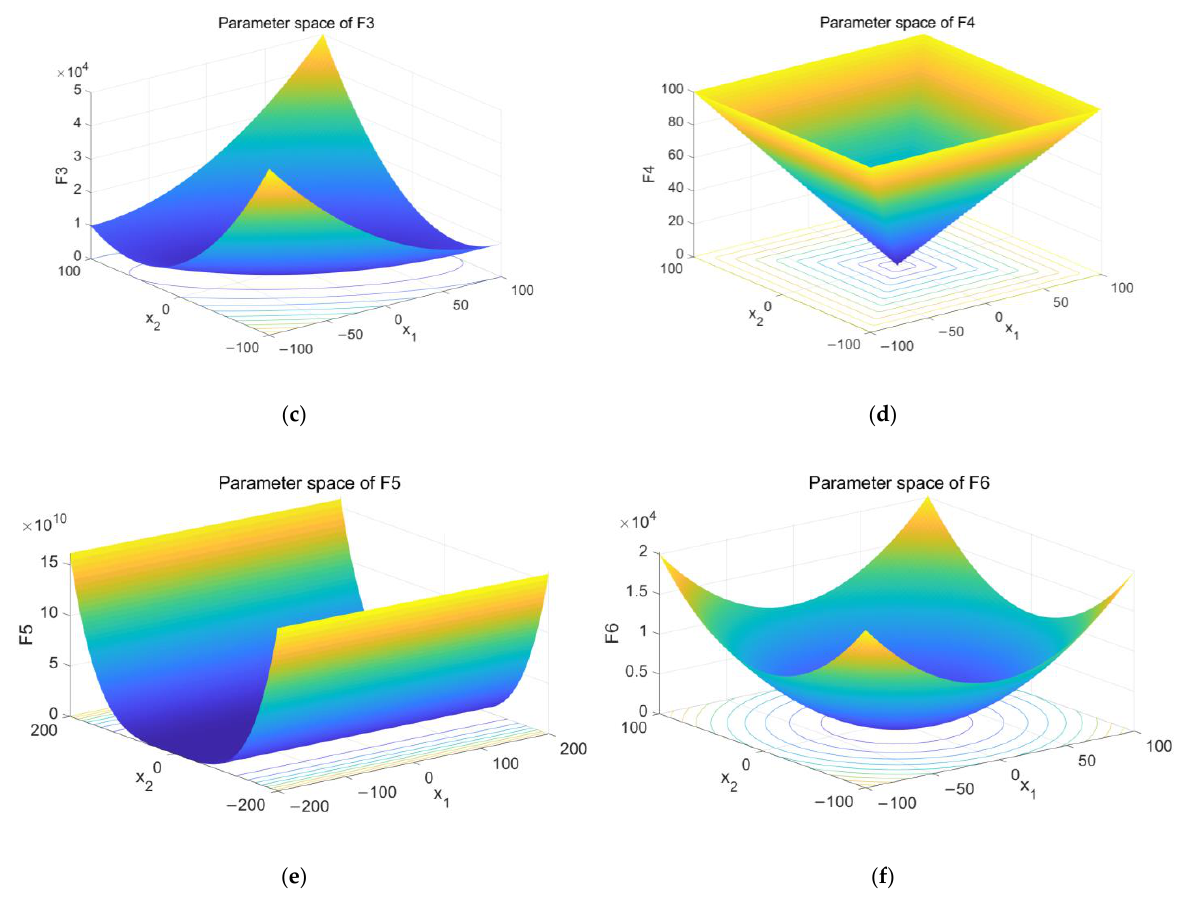
Figure 5. The results of parameter space. ( a ) The parameter space of F1 and ( b ) the parameter space of F2 and ( c ) the parameter space of F3 and ( d ) the parameter space of F4 and ( e ) the parameter space of F5 and ( f ) the parameter space of F6. Table 2. Details of the unimodal test function.